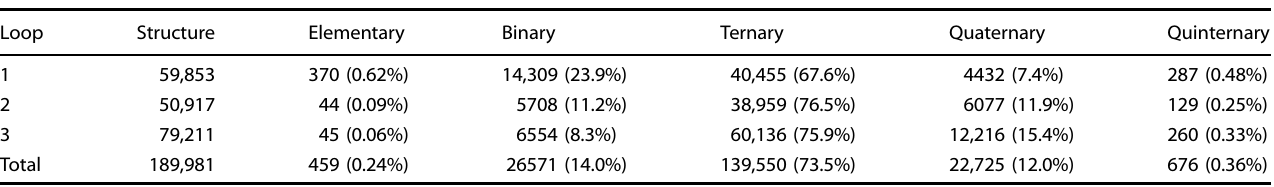
Table 1. The number of new structures (not in the database) at each iteration.